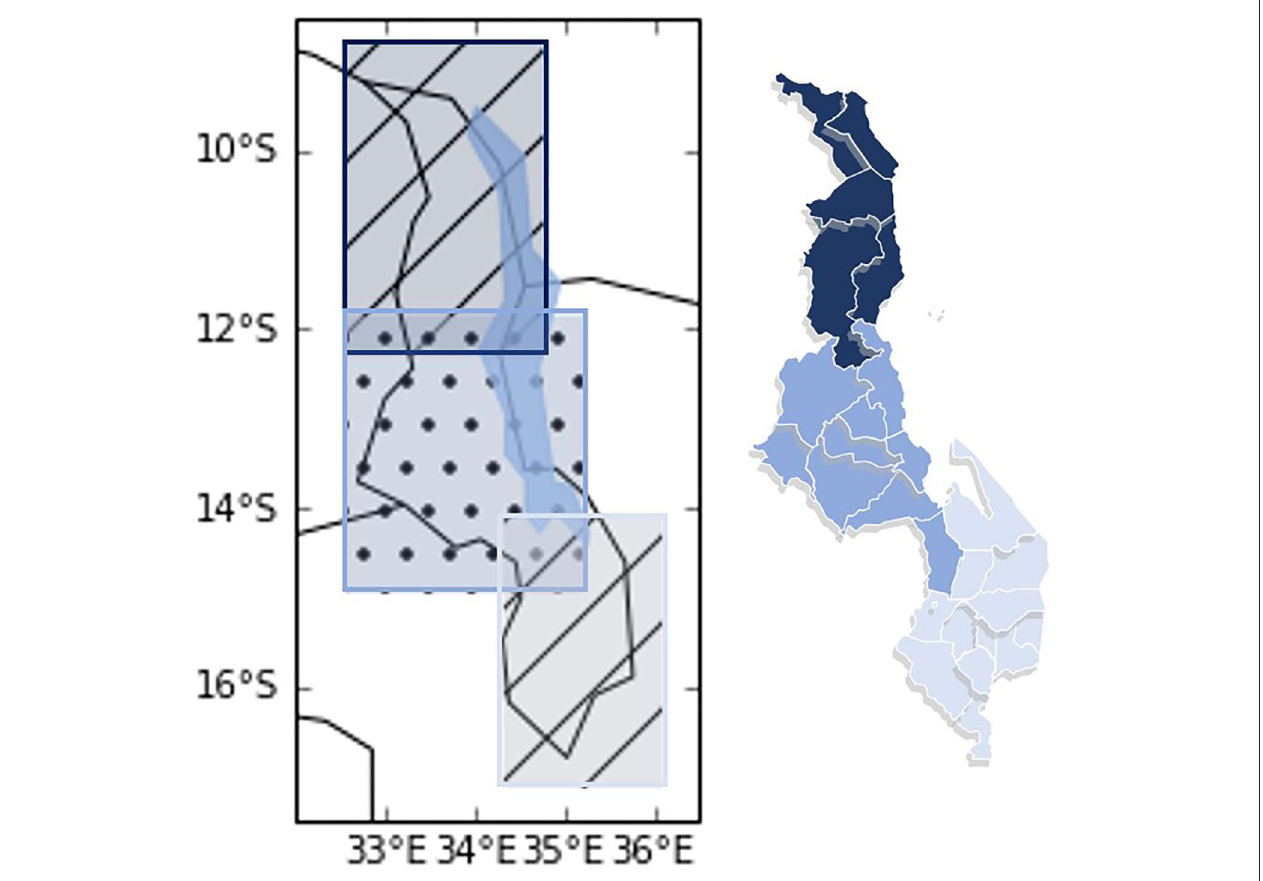
FIGURE 1 | Map of Malawi represented with geographical coordinates (left) and based on actual land boundary (right). The map on the left shows the data boundary used in this assessment. Northern Malawi is indicated by the hatched area at the top (32.5 to 35 degrees East and − 8.5 to − 12.5 degrees South), Central Malawi is indicated by the dotted area in the center (32.5 to 35.5 degrees East and − 11.5 to − 15 degrees South), and Southern Malawi is indicated by the hashed area at the bottom (34 to 36.5 degrees East and − 14 to − 17.5 degrees South). Black lines show national borders and the solidly shaded gray-blue area is Lake Malawi. The map on the right shows the actual land boundary and the district borders (white lines) with Northern Malawi in the darkest shade, Central Malawi in the mid-shade, and Southern Malawi in the lightest